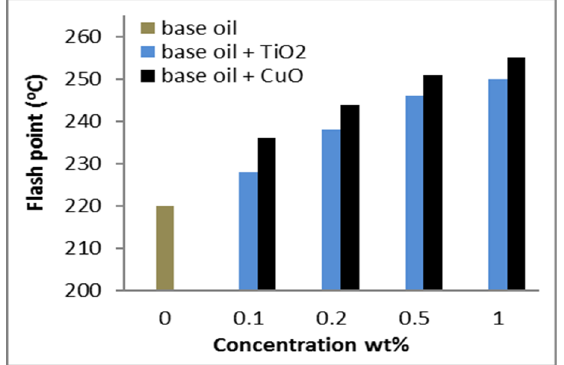
Fig. 9. The flash point values of parent oil and nano- lubricant.